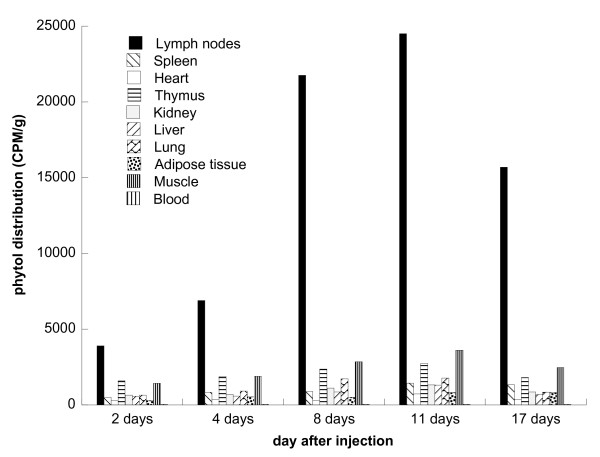
Tissue distribution of tritium-labeled phytol in rats. Biodistribution was estimated as relative counts per minute per gram of tissue. A large fraction of phytol remained as a depot in the injection site (> 90%, not shown). Besides that, the inguinal lymph nodes were the primary tissue for accumulation of phytol. The distribution of phytol to the inguinal lymph nodes showed the highest accumulation > 1 week after injection and showed a reduction after 2 weeks. Values are means from groups of four animals.